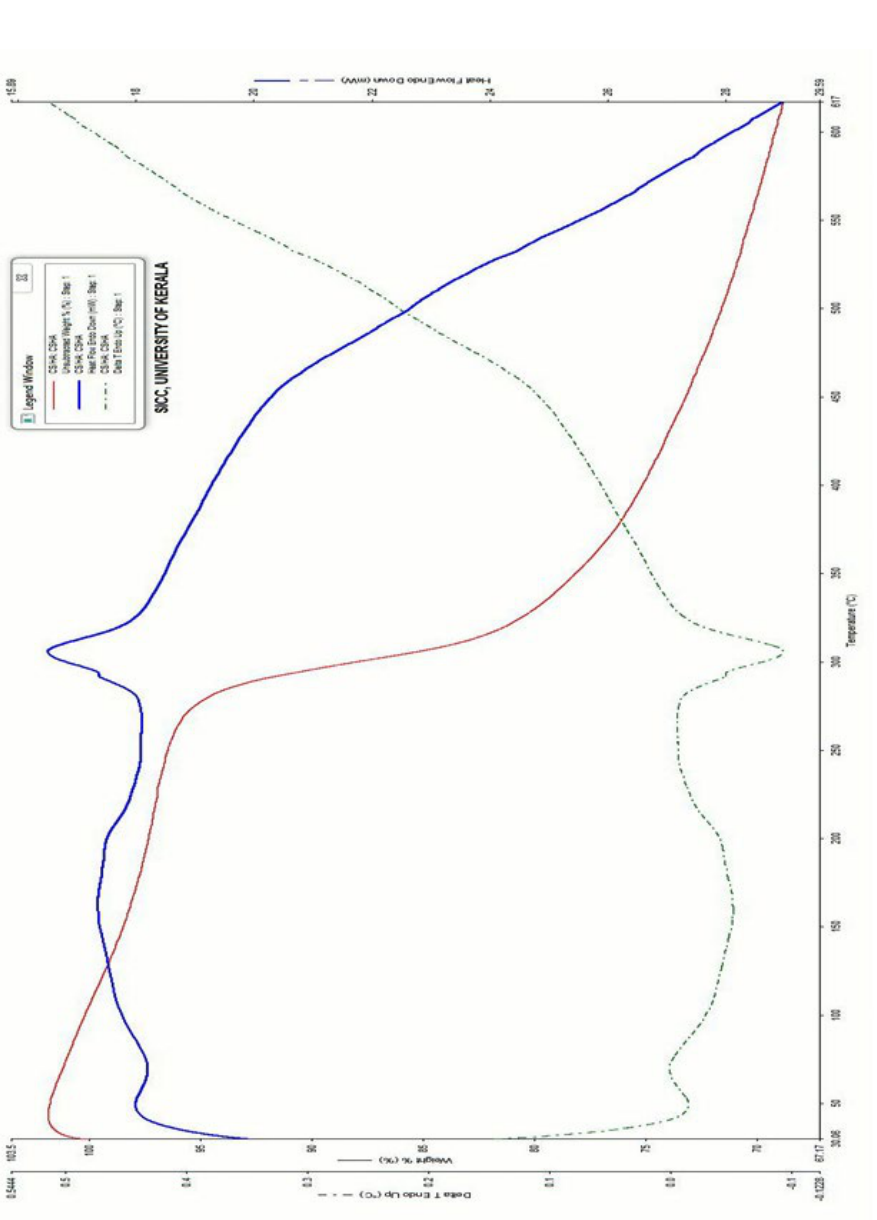
Fig. 5. TG- DTC- DSC curves of chitosan/Hydroxyapatite nanocomposite: The composite showed weight loss at 30-120°C, 270-320°C and 320-600°C. The weight loss at 30-120°C could be due to the release of water present in the sample. However, at 270-320°C and 320- 600°C, the weight loss can be attributed to the thermal combusting of